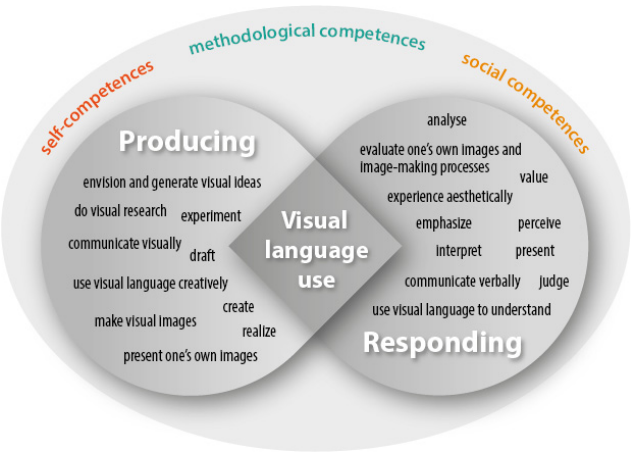
Figure 2. Skills and subskills of the Common European Framework of Visual Competency (CRFR_VC) by Ildikó Biró, 2022, based on (Schönau et al. 2020).